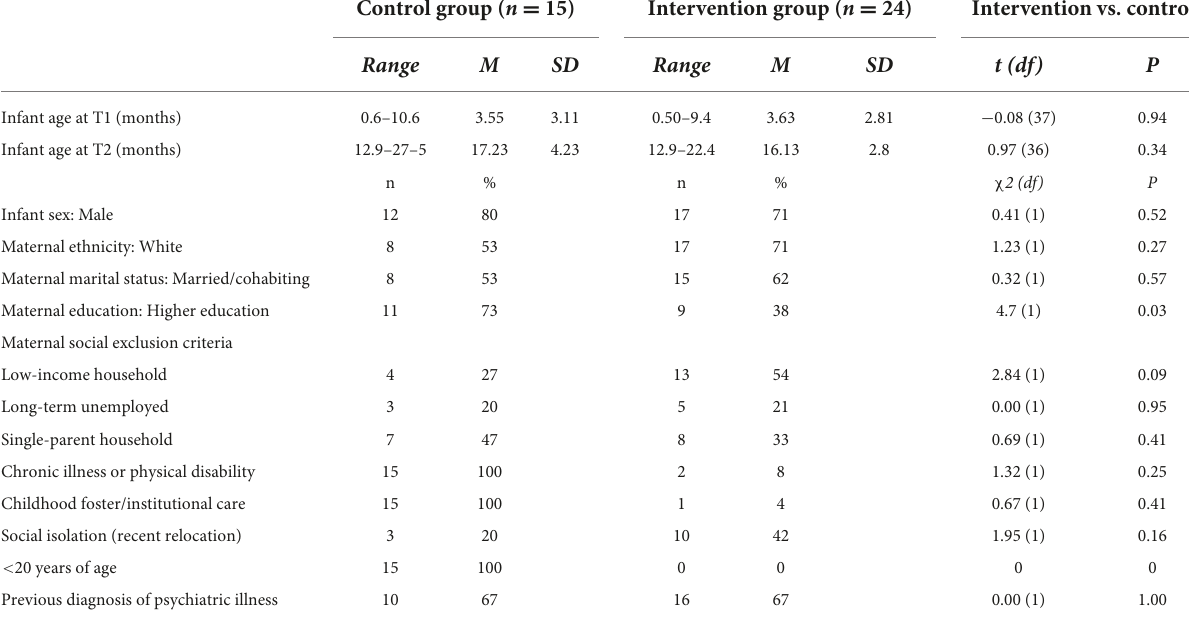
TABLE 1 Demographic variables for the intervention and control groups. Control group ( n = 15) Intervention group ( n = 24) Intervention vs.